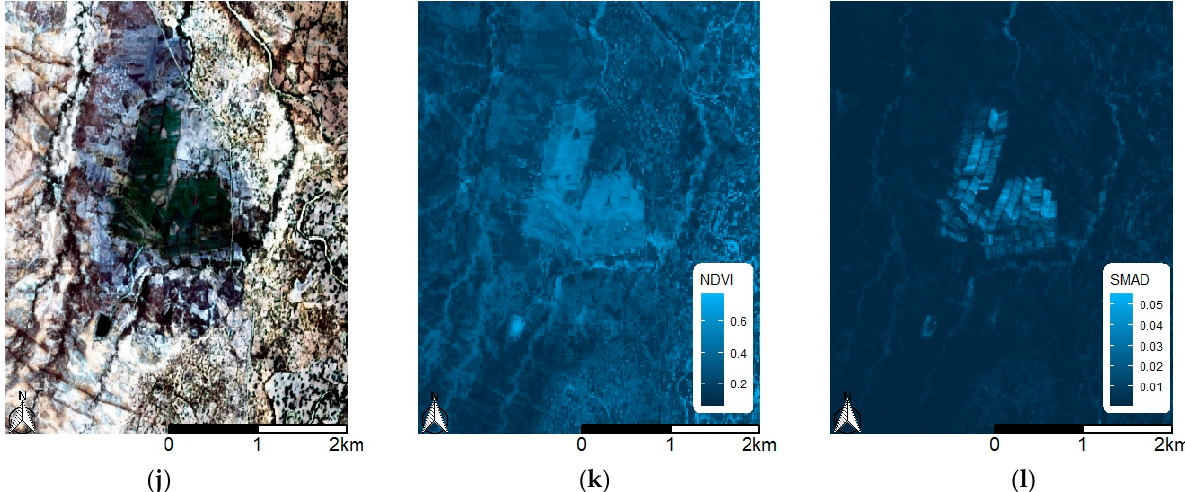
Figure 2. Images of the ( a – c ) Ord River, ( d – f ) Silalatshani, ( g – i ) Nabusenga, and ( j – l ) Lungwalala irrigation schemes showing ( a , d , g , j ) the calculated geomedian true color composite image, ( b , e , h , k ) a single band image for Normalized Difference Vegetation Index (NDVI) calculated on the geomedian, and ( c , f , i , l ) a single band image for the calculated spectral median absolute deviation (SMAD).